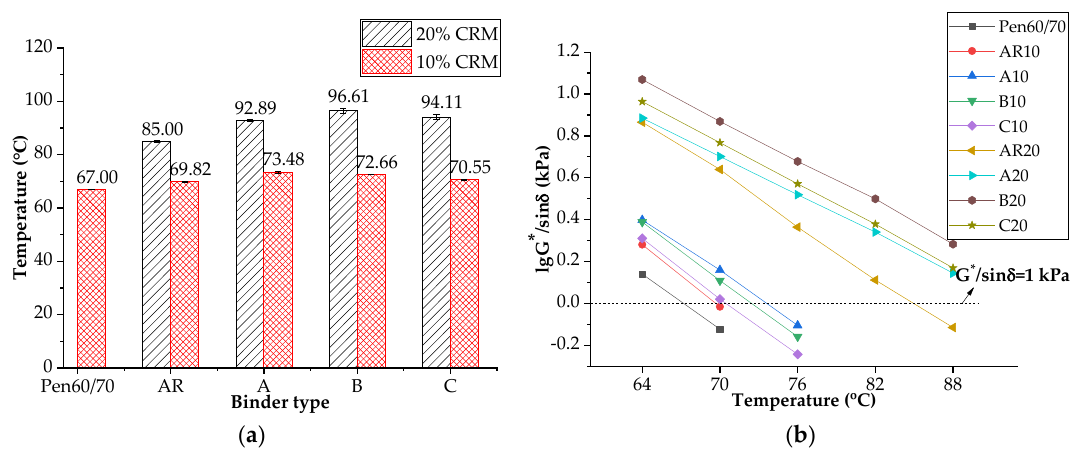
Figure 5. Rutting performance of asphalt binders: ( a ) failure temperatures; ( b ) Logarithm of G * /sin δ values (rutting factors).